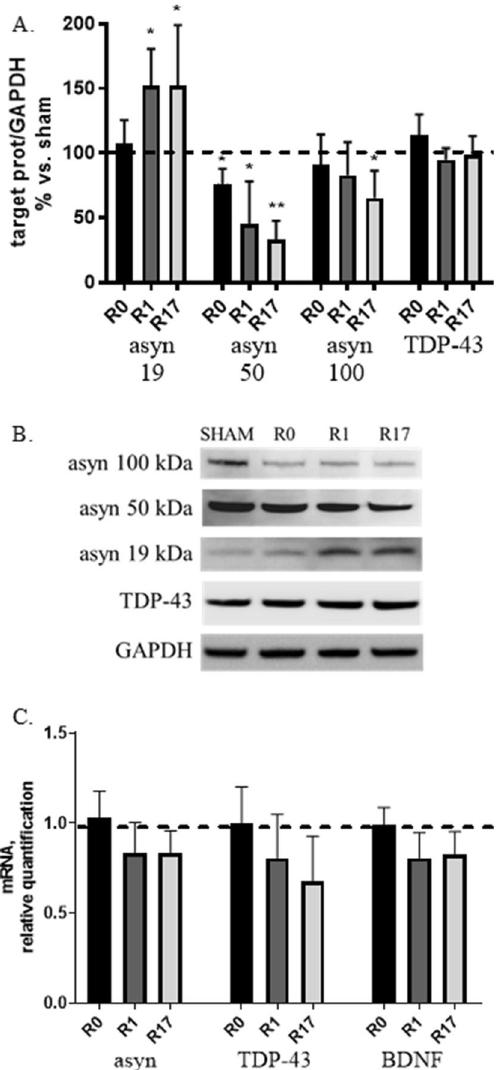
Figure 1. Effects of DCS on protein ( A , B ) and gene ( C ) expression of asyn, TDP-43 and BDNF (mRNA levels only) in SH-SY5Y cells under basal conditions at the end of stimulation (R0), after 1 and 17 h (R1 and R17). Reduced oligomeric/aggregated and increased monomeric asyn forms were found in DCS-treated cells ( A , B ). ( B ) Representative Western blot image showing immunoreactivity at different time points (R0, R1 and R17) for monomeric (19 kDa) and oligomeric/aggregated (50 and 100 kDa) asyn forms, TDP-43 and GAPDH, used as internal standard, in cells exposed to DCS or sham. Full-length blots are presented in Supplementary M&M. (N = 3; **p < 0.01, *p < 0.05 vs.